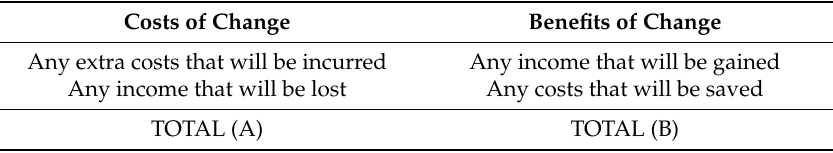
Table 4. Calculating the costs and benefits of a planned change with a partial